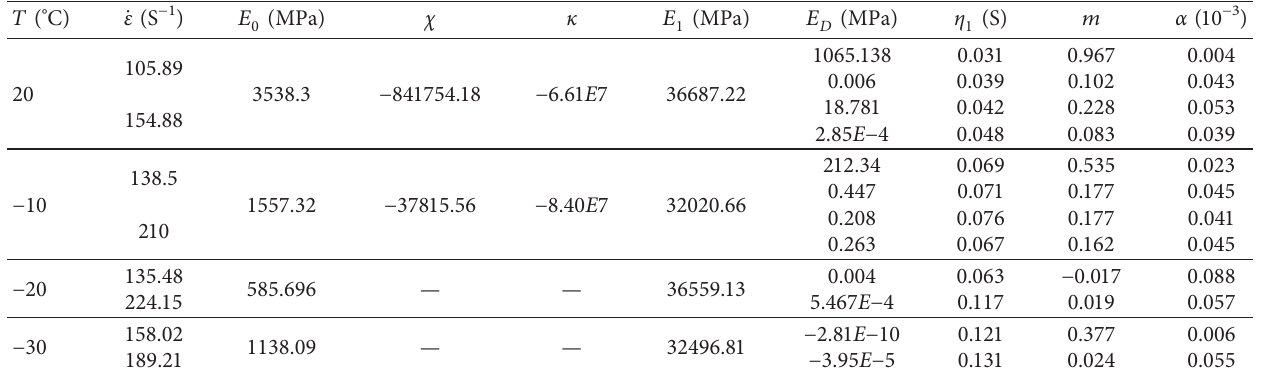
Table 2: Fitting parameters for sandstone with different strain rates at different